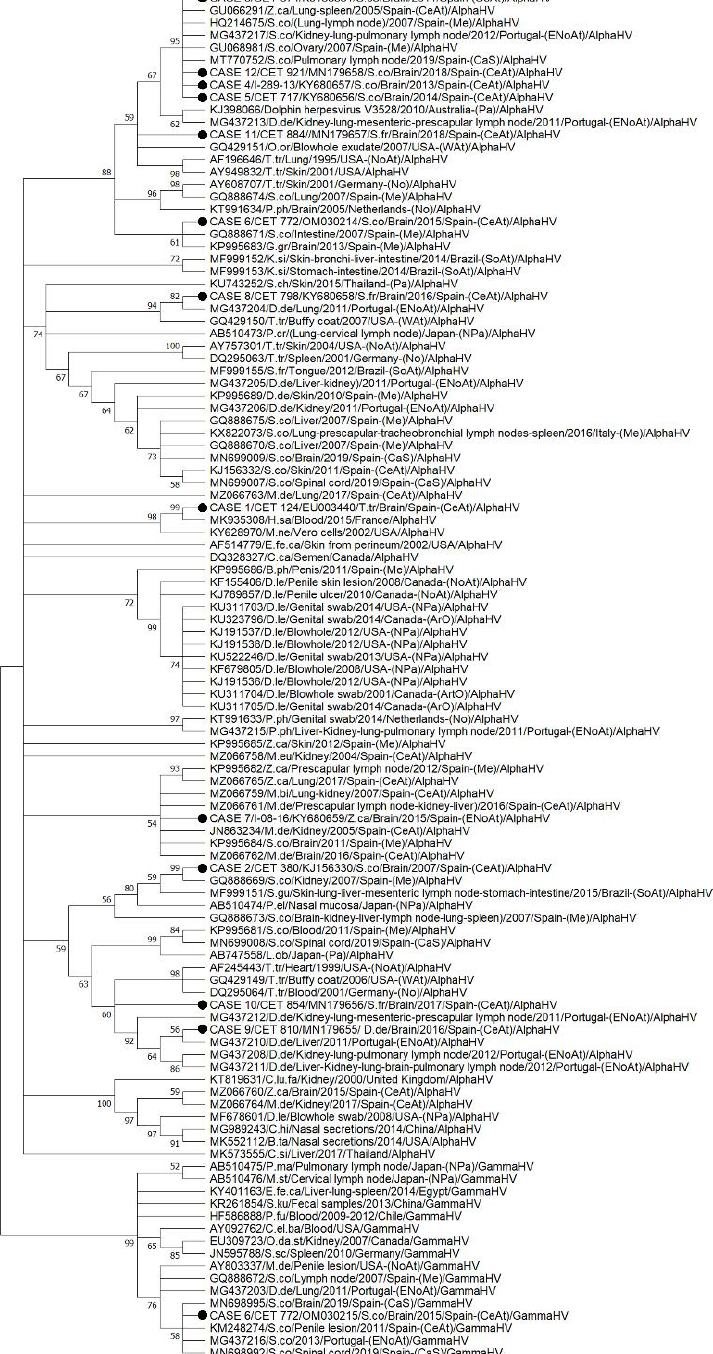
Figure 8. Nucleotide phylogenetic tree representing the relationships among cetaceans HVs. The phylogenetic tree was based on the herpesvirus DNA polymerase gene and constructed using the